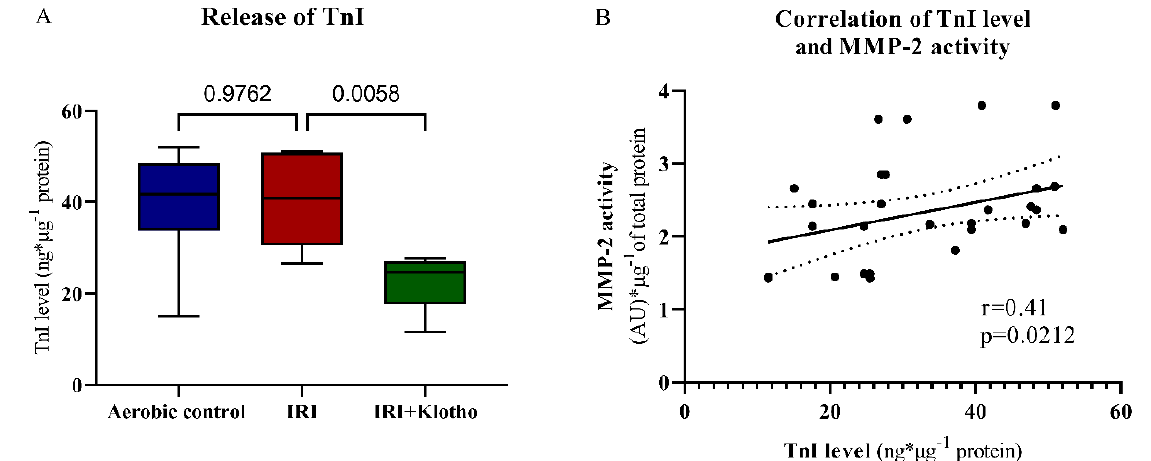
Figure 5. ( A ) The concentration of MLC1 in cell supernatants (S1) was tested by ELISA and normalized to the total protein concentration; n aerobic = 5; n IRI = 7; n IRI+Klotho = 6; ( B ) Correlation of MLC1 concentration in cell supernatants (S1) and MMP-2 activity; lines—mean; dotted lines—standard error; AU—arbitrary unit; MLC1—myosin light chain 1; MMP-2—matrix metalloproteinase 2; boxes—25–75% percentile, whiskers—min to max + median.